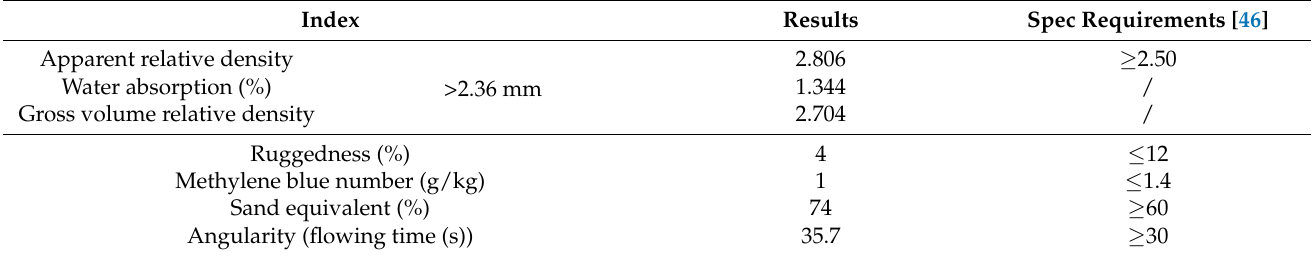
Table 3. Technical indices of the limestone.